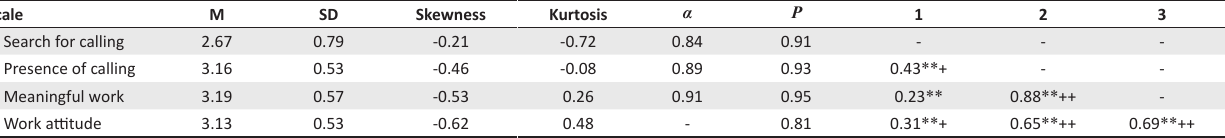
TABLE 4: Descriptive statistics, Raykov’s rho and correlation coefficients of the scales. Scale